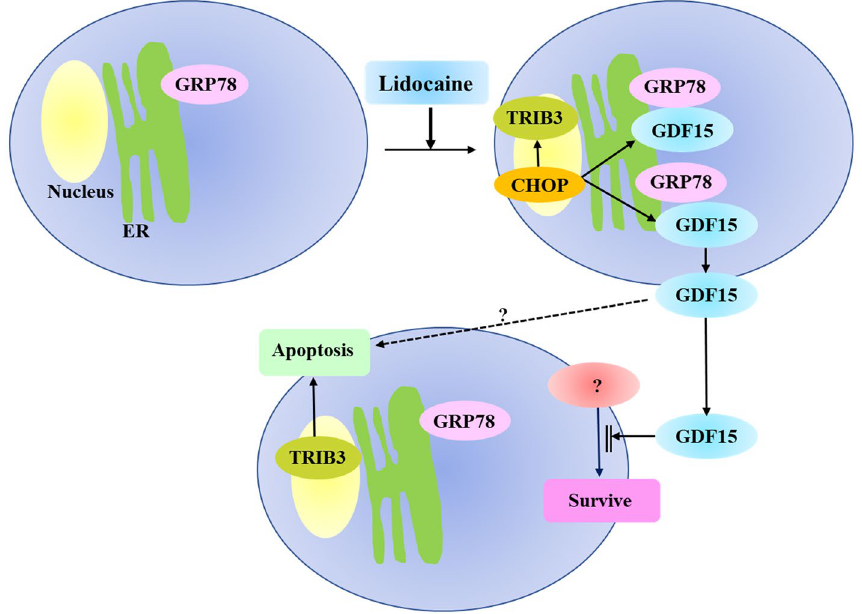
Figure 7. Proposed model of growth suppression and apoptosis caused by lidocaine-induced GDF-15 and TRIB3. Lidocaine induces expression of transcription factor CHOP, which transactivates GDF-15 and